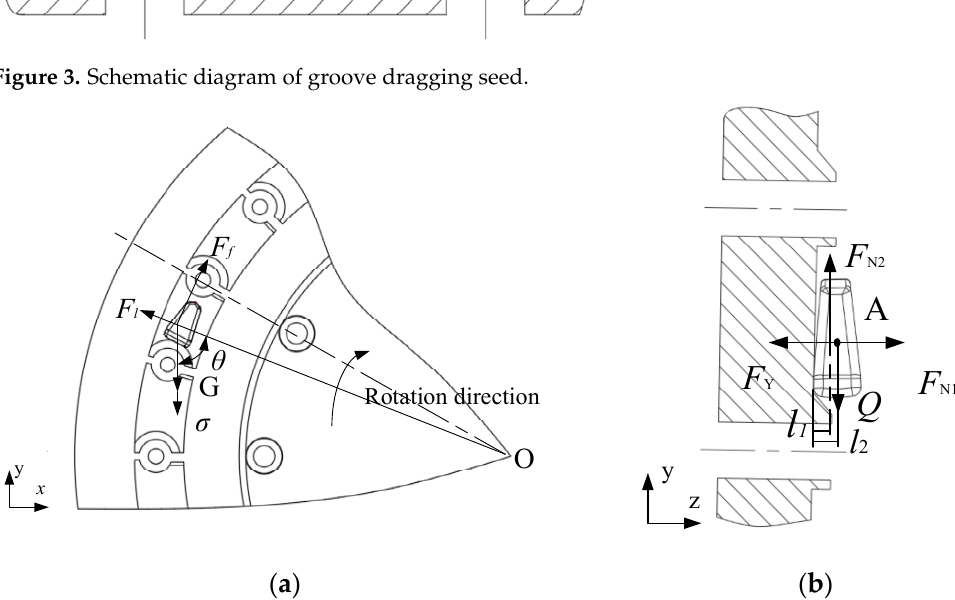
Figure 4 . Force analysis of maize seeds in the concave groove. ( a ) x–y plane; ( b ) z–y plane. Figure 4. Force analysis of maize seeds in the concave groove. ( a ) x – y plane; ( b ) z – y